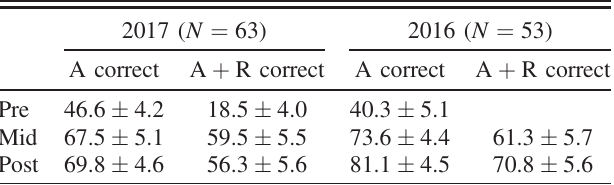
TABLE II. The mean percentage of correct responses for the pre-, mid-, and post-tests, considering only students ’ answers (A) and considering both answer and reasoning (A þ R). Errors are the standard errors on the mean.